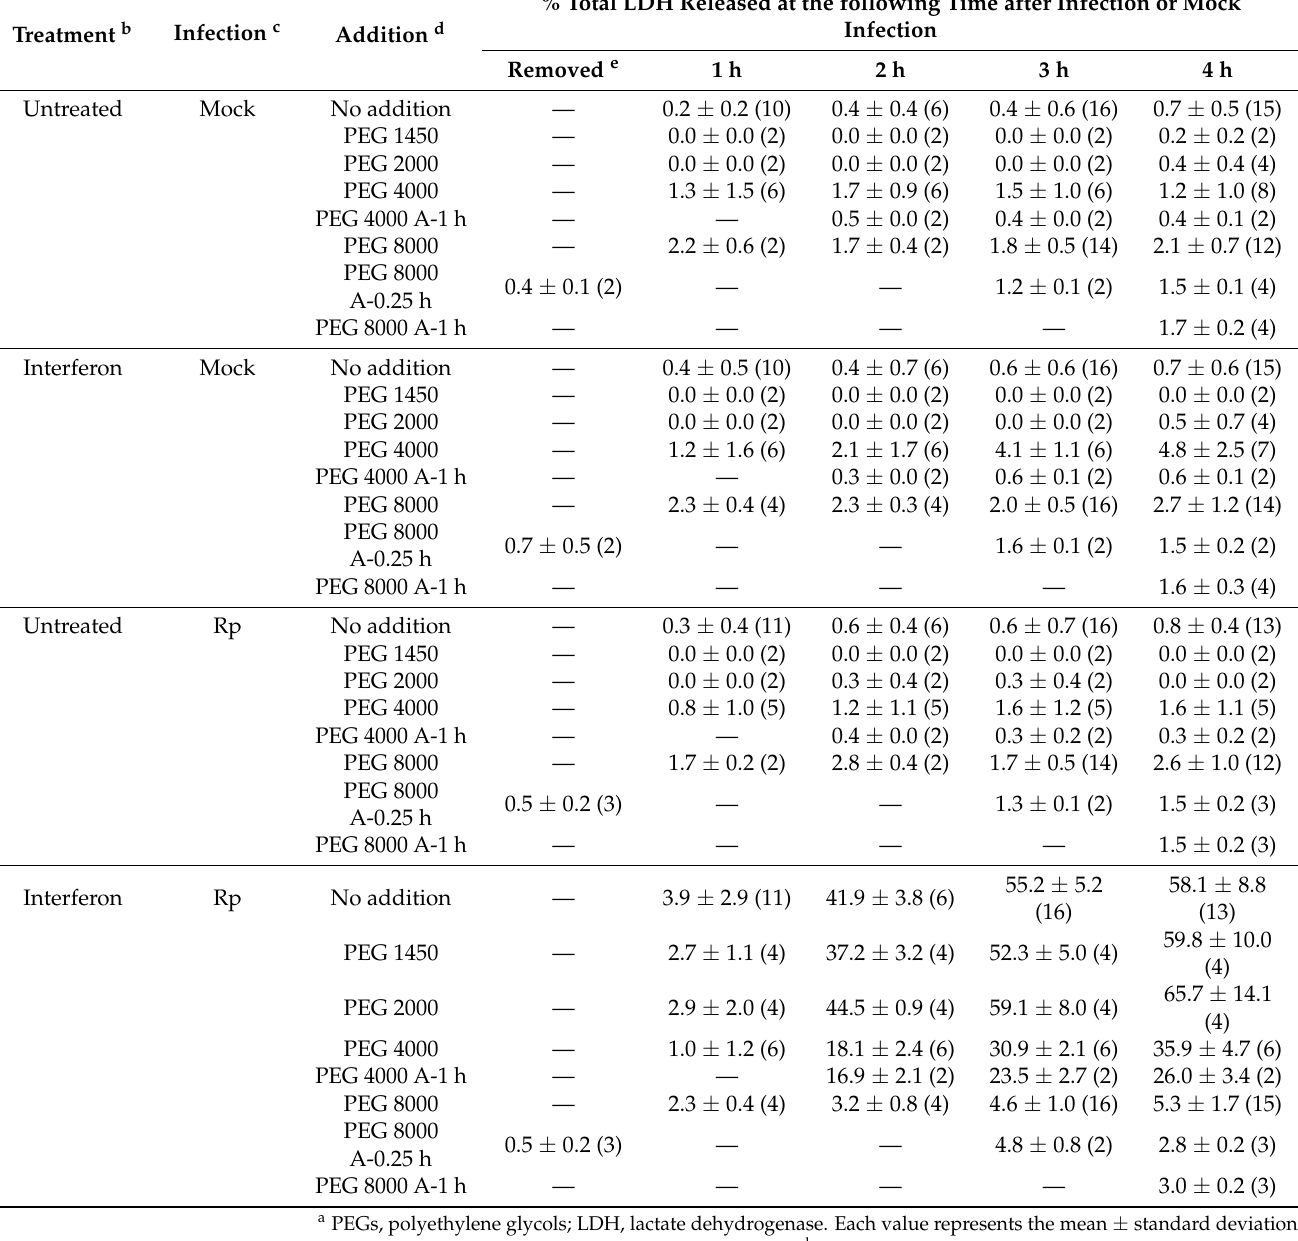
Table 1. Effect of PEGs on R. prowazekii -induced release of LDH by interferon-treated C166 cells a .